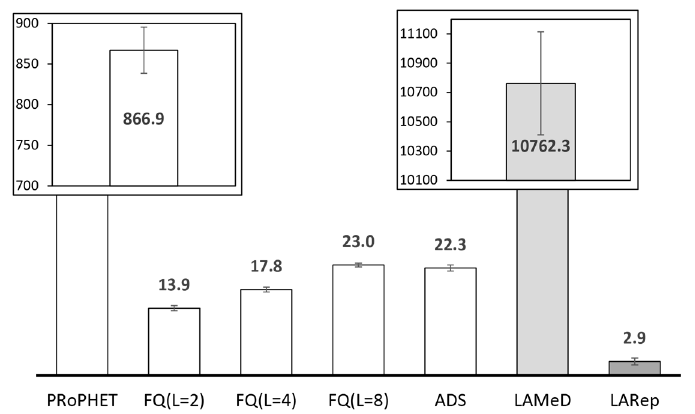
Figure 15. Transmission overhead in the Skudai scenario. Information 2017, 8, 143